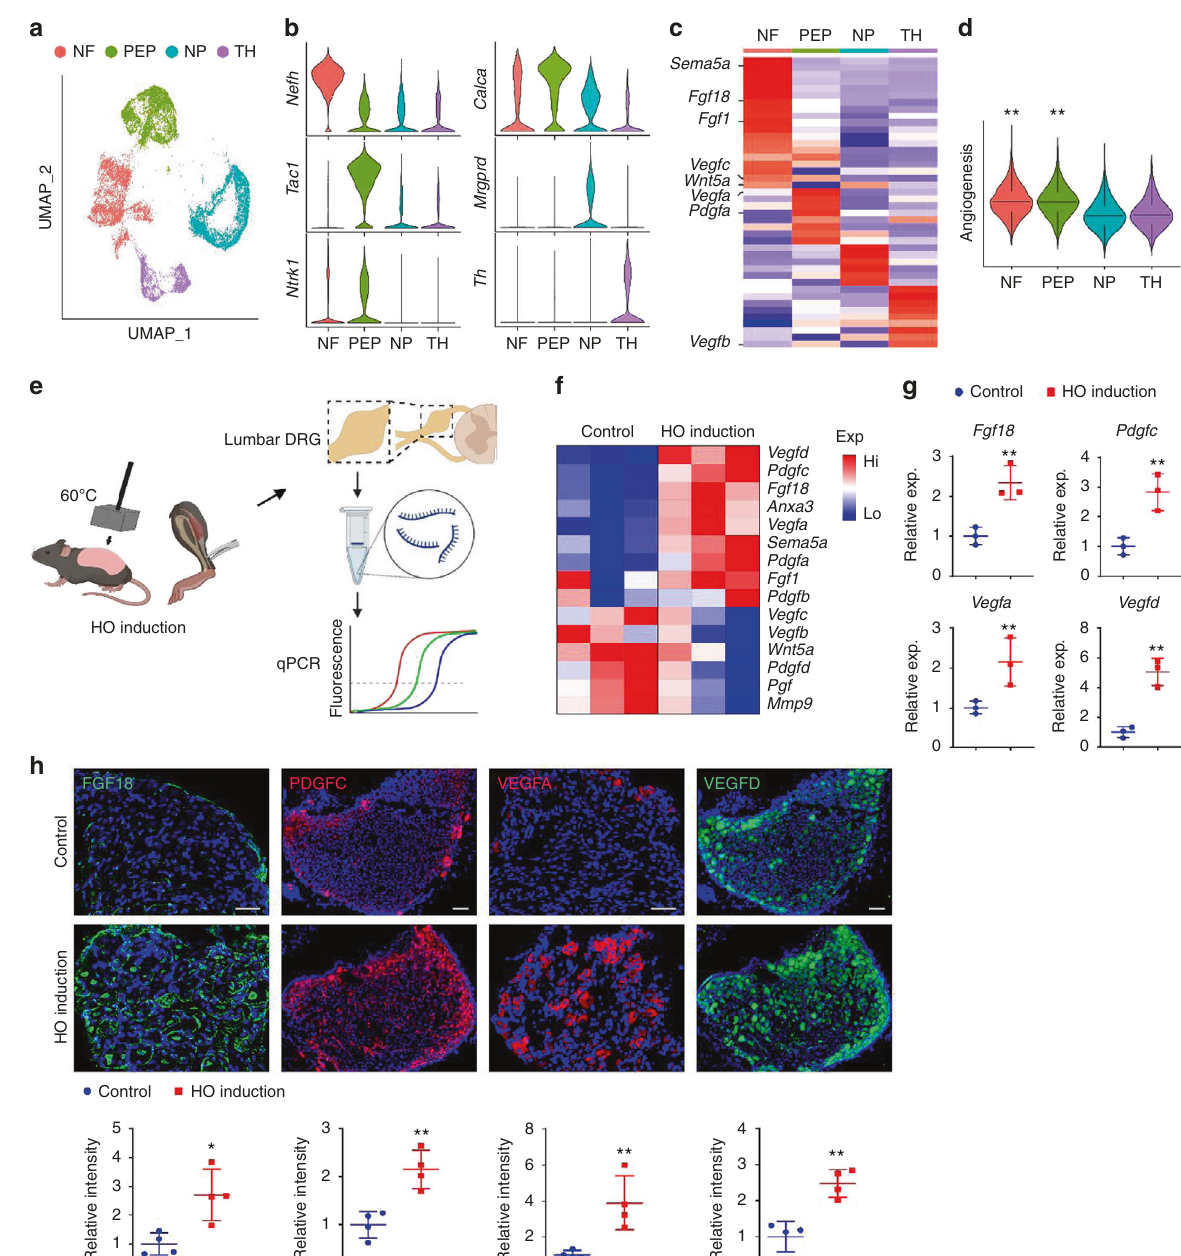
Fig. 5 TrkA + peripheral nerves express key angiogenic genes after soft tissue trauma. a – d Re-analysis of scRNA-Seq of mouse lumbar DRG neurons (8 – 12 weeks old male C57BL/6 J mice, n = 3 mice, 11 191 neuronal DRG cells were examined) ( a ) UMAP visualization of 4 cell clusters including Neuro fi lament (NF), Peptidergic nociceptors (PEP), Non-peptidergic (NP) and Tyrosine hydroxylase (TH) in pooled cells. b Violin plots demonstrating characteristic markers of each cell cluster. Nefh (Neuro fi lament Heavy Chain), Calca (Calcitonin Related Polypeptide Alpha), Tac1 (Tachykinin Precursor 1), Mrgprd (MAS Related GPR Family Member D), Ntrk1 (Neurotrophic Receptor Tyrosine Kinase 1), Th (Tyrosine Hydroxylase). c Heatmap of angiogenic gene expression among each cell cluster. Sema5a (Semaphorin 5 A), Fgf18 (Fibroblast Growth Factor 18), Fgf1 (Fibroblast Growth Factor 1), Vegfc (Vascular Endothelial Growth Factor C), Wnt5a (Wnt Family Member 5 A), Vegfa (Vascular Endothelial Growth Factor A), Pdgfa (Platelet Derived Growth Factor Subunit A), Vegfb (Vascular Endothelial Growth Factor B). d Module score analysis of angiogenic genes among each cell cluster. e – g qPCR analysis of angiogenic gene expression among ipsilateral lumbar DRGs after HO induction, in comparison to uninjured control. Ipsilateral L4-L6 pooled for analysis. e Schematic of qPCR analysis of angiogenic gene expression among ipsilateral lumbar DRGs after HO induction. Created in Biorender.com. f Heatmap of 15 pro-angiogenic genes enriched in Ntrk1 -expressing neurons after HO induction, in comparison with uninjured control. Analysis performed at 3 d post-injury. g Representative most up-regulated genes upon HO induction, including Fgf18 , Pdgfc, Vegfa , and Vegfd . h Representative immuno fl uorescent staining of ipsilateral L4 DRG after HO induction in relation to uninjured control, including FGF18 (Fibroblast Growth Factor 18), PDGFC (Platelet Derived Growth Factor Subunit C), VEGFA (Vascular Endothelial Growth Factor A), and VEGFD (Vascular Endothelial Growth Factor D). Analysis performed at 3 day post-injury, and quanti fi cation performed in relation to uninjured control. Scale bars: 100 μ m. n = 3 or 4 animals per group. Individual dots in scatterplots represent values from single animal measurements, while mean and one SD are indicated by crosshairs and whiskers. * P < 0.05; ** P < 0.01. A two-tailed student ’ s t test was used ( g , h ). Non-parametric data was analyzed using the Kolmogorov – Smirnov test ( d